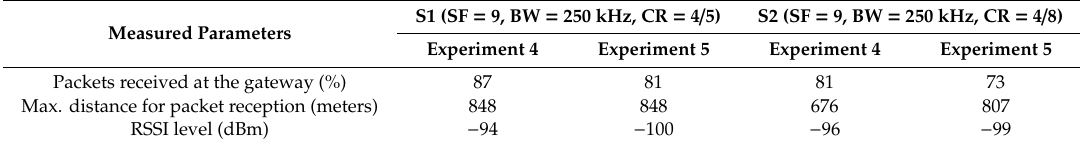
Table 3. Better settings in both Experiments 4 and